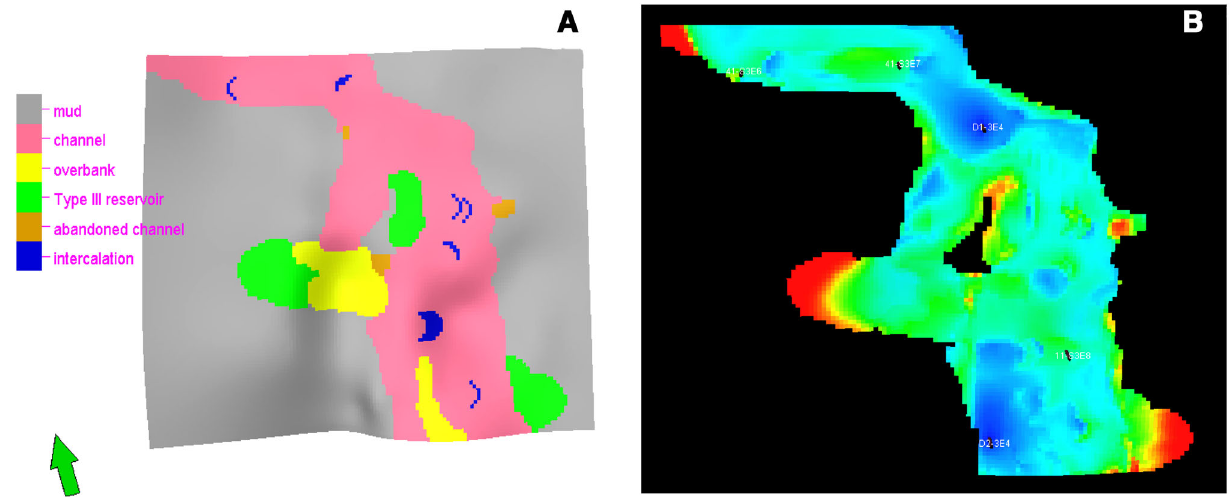
Fig. 13 The maps of the facies model and simulation result in the study area. a Facies model of the S2 layer set in the study area; b simulation result of the S2 layer set in the study